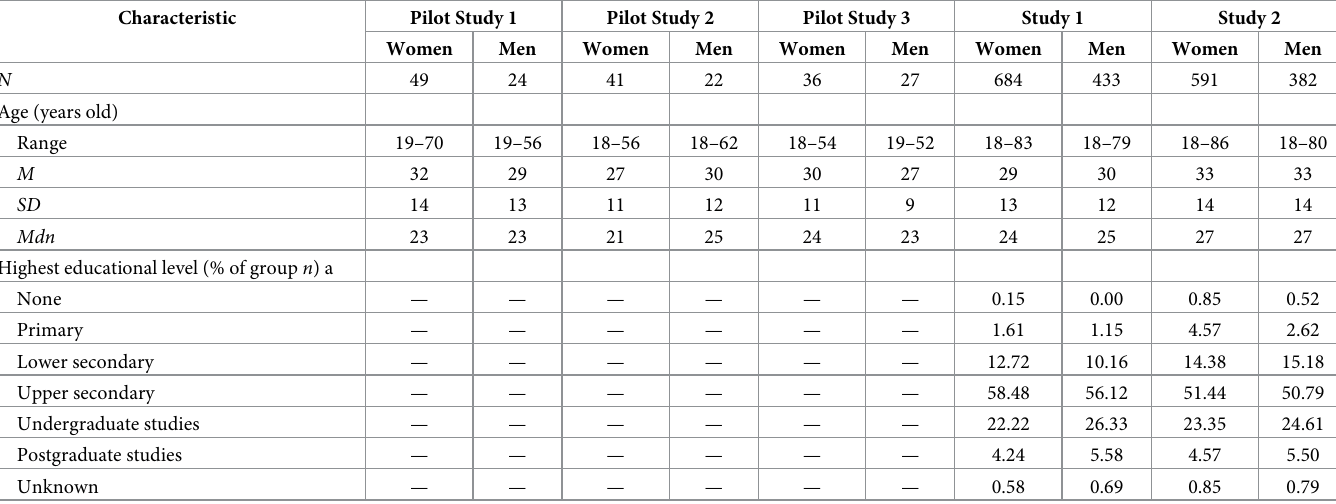
Table 1. Demographic characteristics of study samples in women and